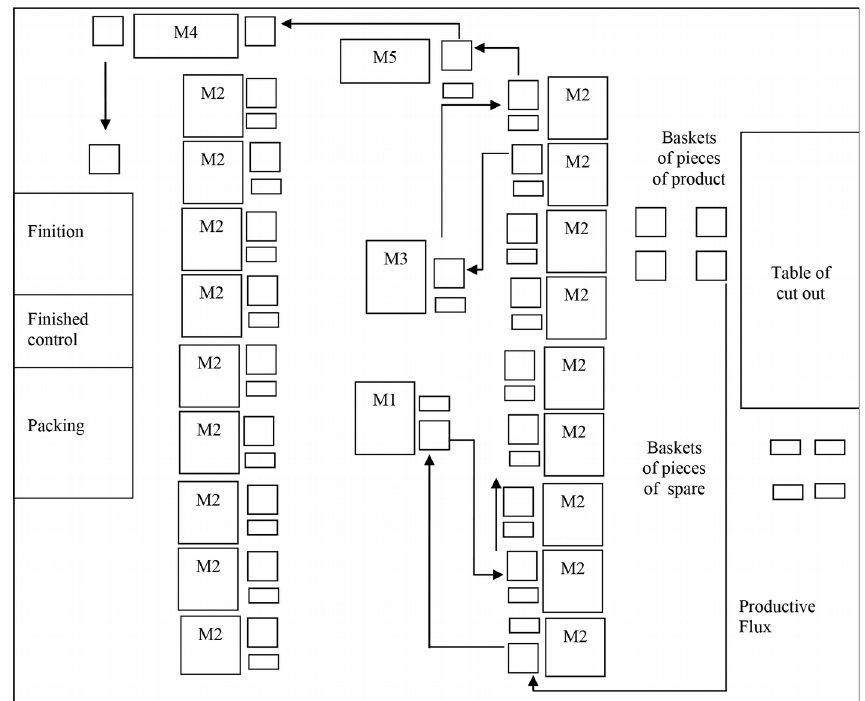
Figure 16. Productive flux of the assembly